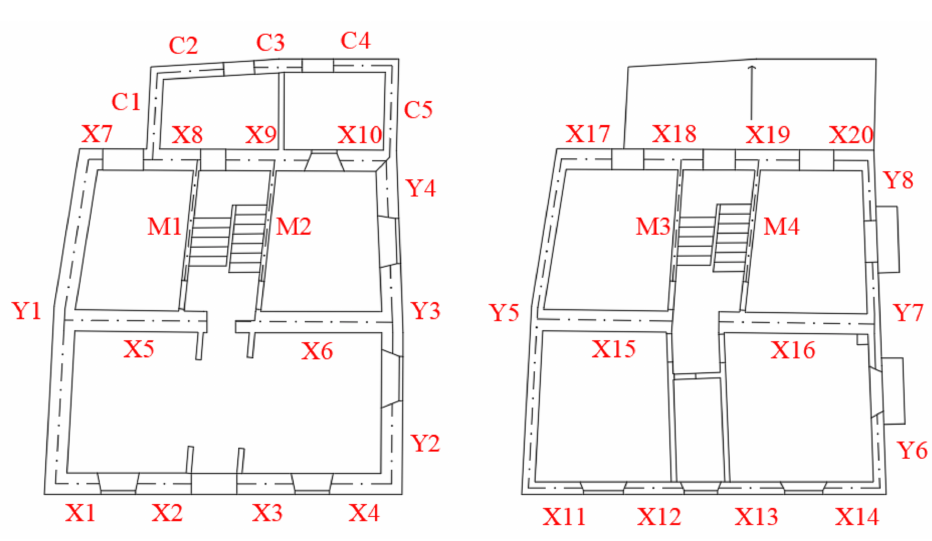
Figure 7. Legend of masonry